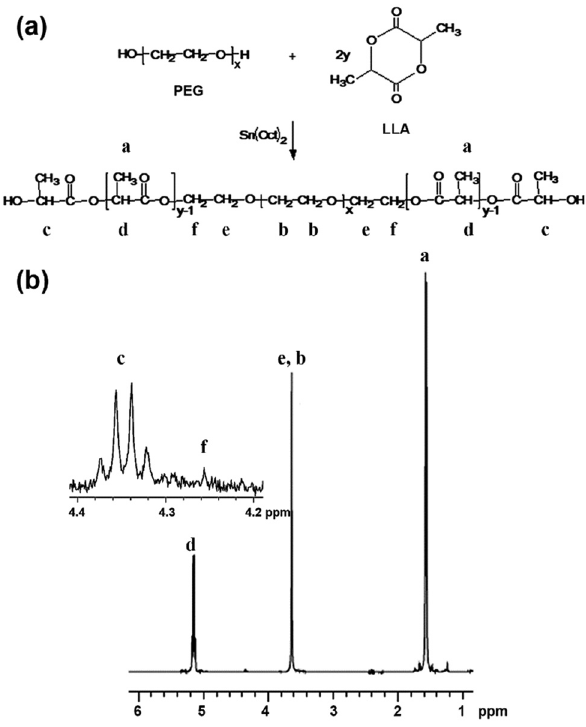
Figure 1: ( a ) Ring - opening polymerization reaction of PLLA - PEG - PLLA and ( b ) 1 H - NMR spectrum of PLLA - PEG - PLLA in CDCl 3 at room temperature ( peak assignments as shown )